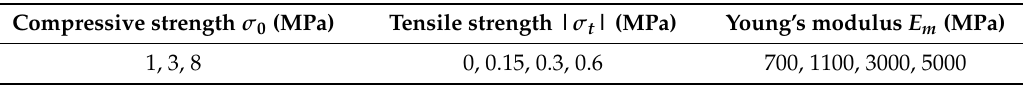
Figure 1. Main geometrical characteristics of masonry cross-section (dimensions in mm). Table 1. Mechanical properties of masonry considered in the numerical investigation.